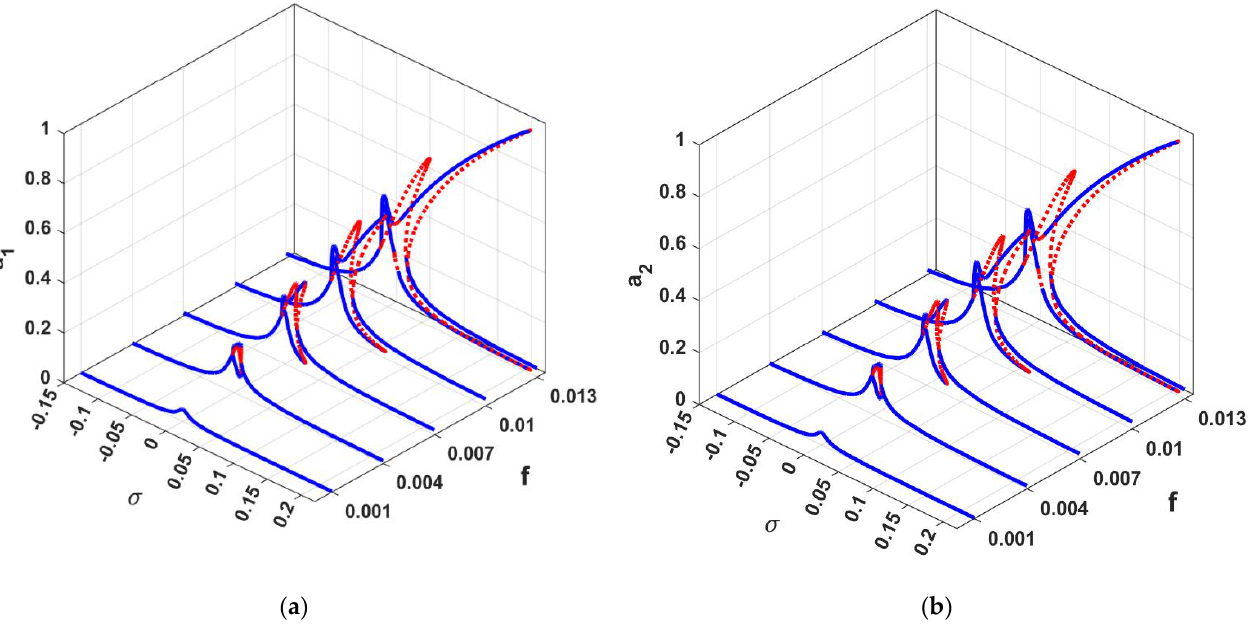
Figure 3. Vibration amplitudes of the rotor system without the LIPPF-controller using 𝜎 as a bifurcation parameter when 𝑓 = 0.001, 0.004, 0.007,0.01, and 0.013 : ( a ) vibration amplitude in 𝑋 1 direction and ( b ) vibration amplitude in 𝑋 2 direction.